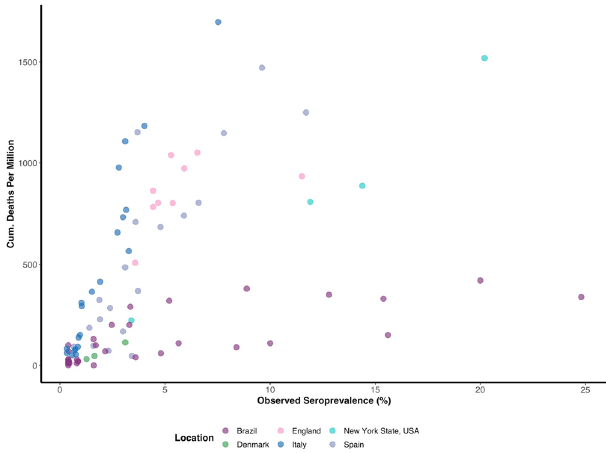
Fig. 6 First-wave data: mortality versus seroprevalence. Relationship between seroprevalence and COVID-19 mortality per 1,000,000 among surveys which could be broken down by region.